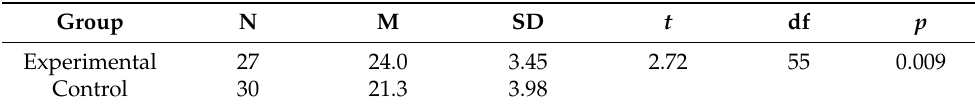
Table 6. Results of the t -test of the EXPL scores.